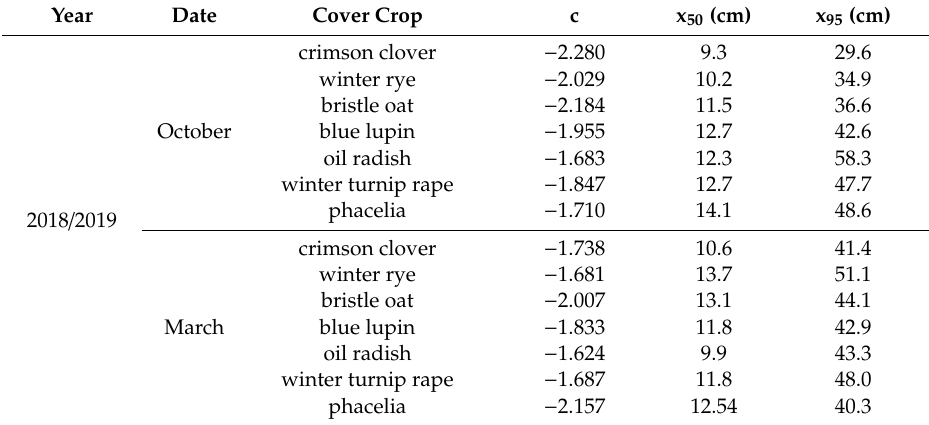
Figure 3. Cumulative distribution of root length of cover crops at different soil depth before winter ( A , B ) and after winter ( C , D ) in seasons 2018/2019 ( A , C ) and 2019/2020 ( B , D ). Cumulative distribution of root length was fitted by non-linear regression using a logistic dose-response curve. Symbols show the means of the measured values ( n = 3). Table 5. Estimated parameters for a logistic curve of cumulative distribution of root length depending on soil depth and calculated x 95 for different cover crops before (October) and after winter (March) in two seasons (2018/2019 and 2019/2020).